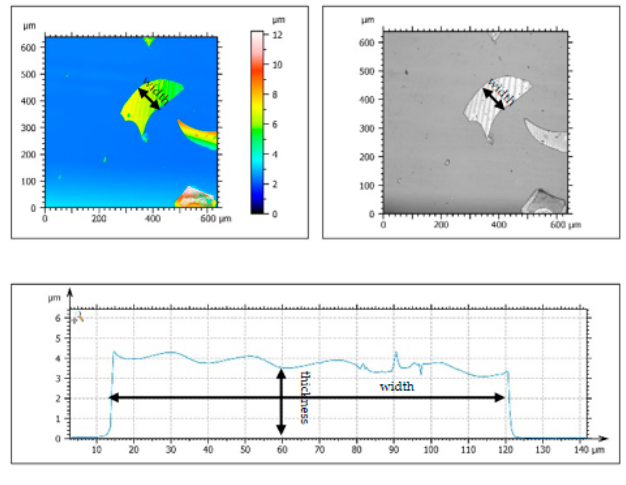
Figure 2. Surface topography of GF.